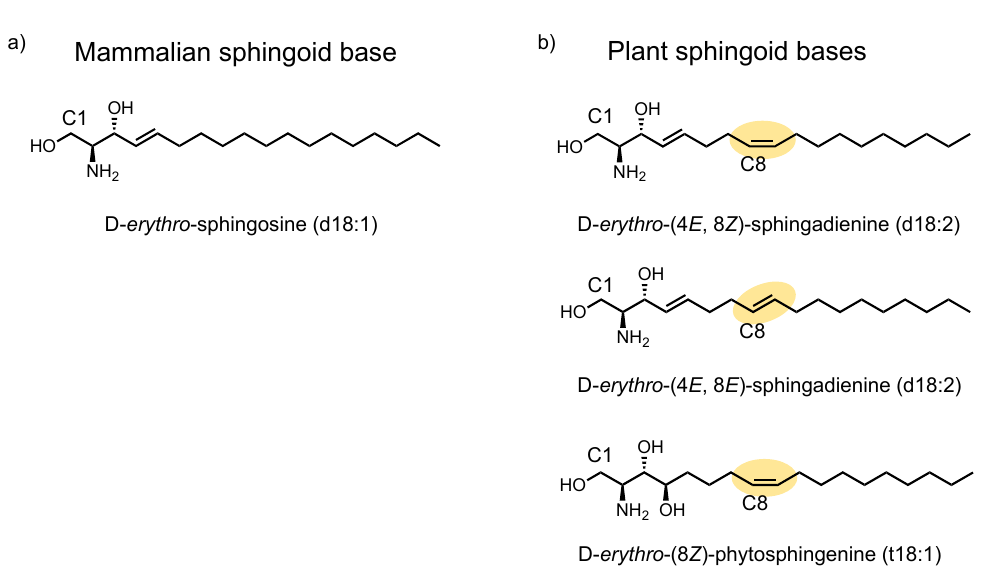
Figure 1. Structures of the mammalian sphingoid base sphingosine ( a ) and plant sphingoid bases sphingadienine and phytosphingenine ( b ).